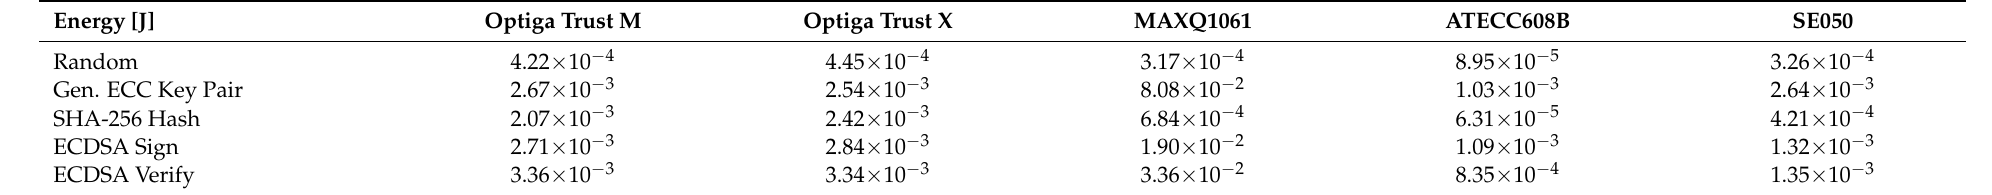
Table A7. Energy consumption of the secure elements without the MCU during the cryptographic primitives (median of values, rounded to 3 significant digits, n = 100).